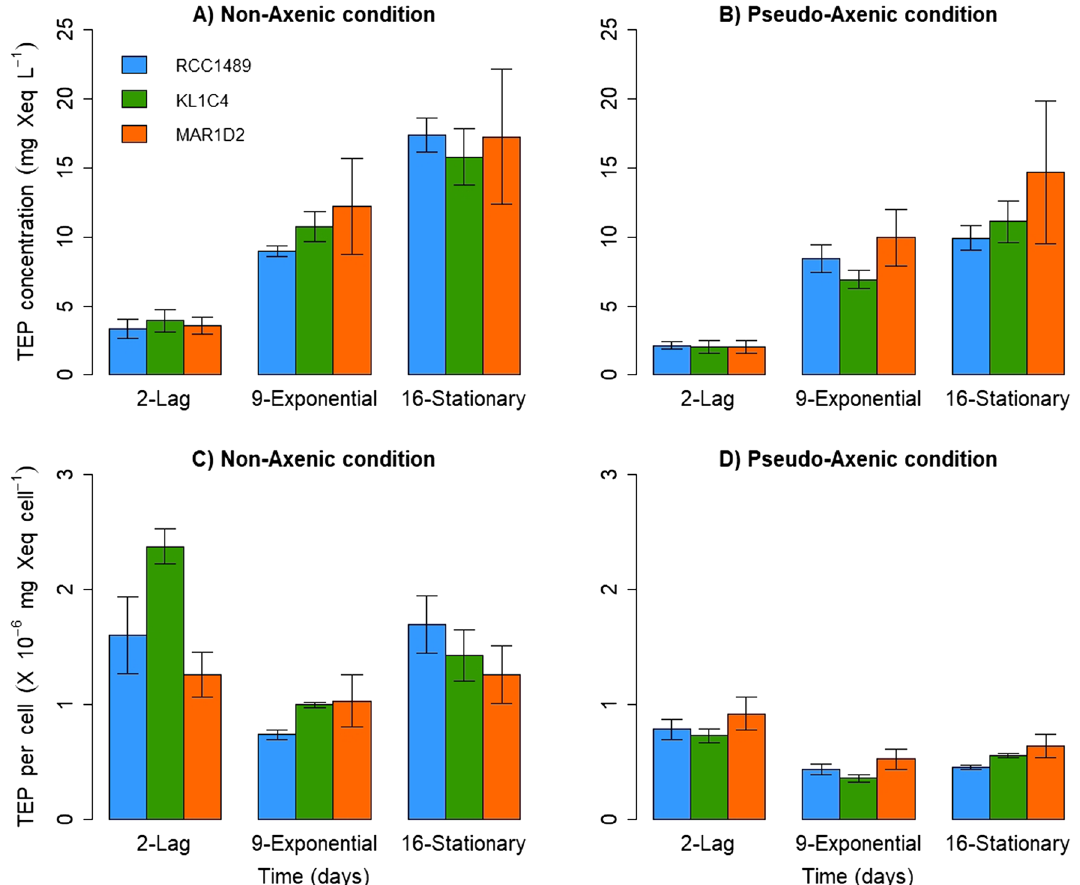
Figure 2. Mean TEP concentrations (mg Xeq L −1 ) measured under ( A ) non-axenic (NA), ( B ) pseudo-axenic (PA) conditions and mean cell normalised TEP production (mg Xeq cell −1 ) estimated under ( C ) NA, ( D ) PA conditions for the three L. chlorophorum strains during the different growth phases. Error bars represent standard deviation (n = 3).